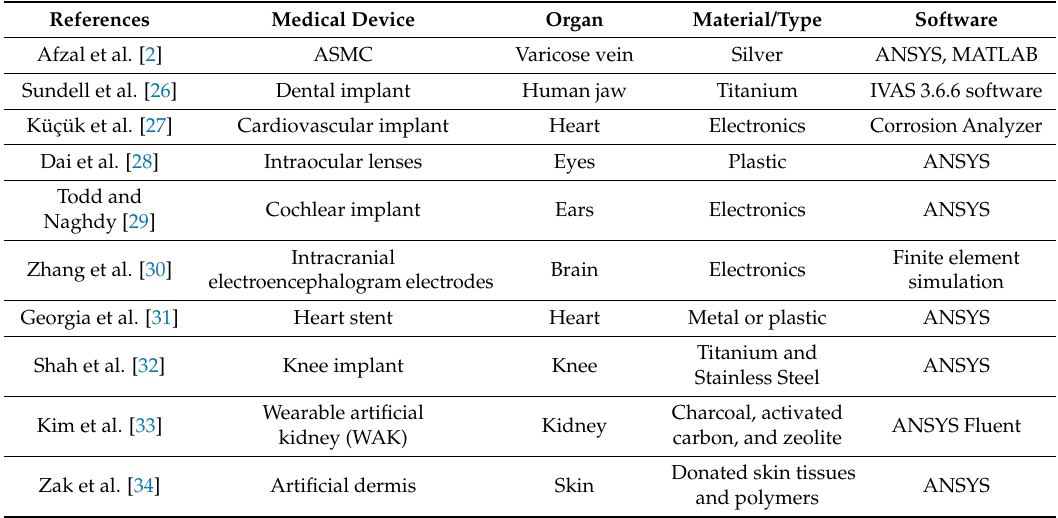
Table 1. Medical devices implant in human body. ASMC: ascending sinusoidal microchannel.